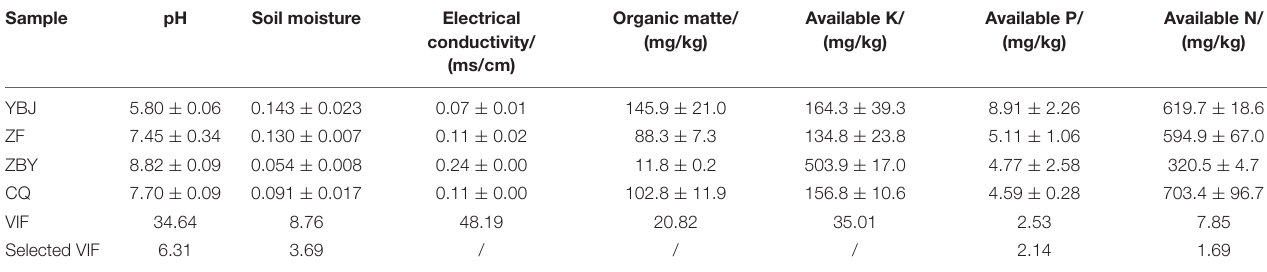
TABLE 3 | Nutrient and chemical properties in the soil of the Oxytropis glacialis root system.